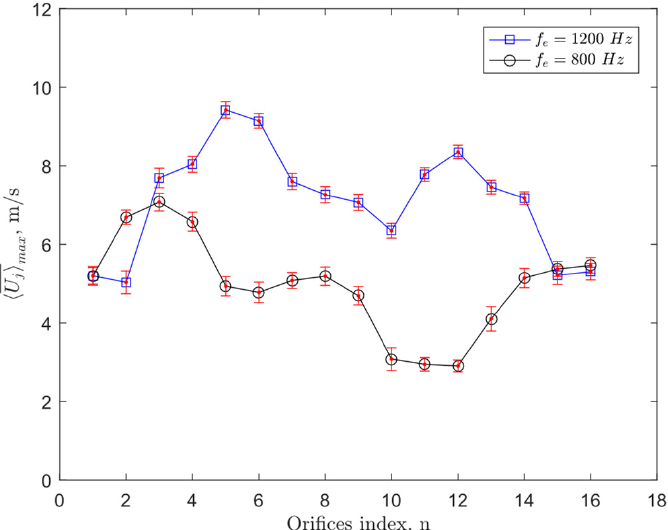
Figure 6. Variation of the peak mean jet velocity during expulsion stroke along the array of orifices at Y/D = 1 (measured at each orifice centreline) for two excitation frequencies ( f e = 800 Hz and 1200 Hz) for the unified-array-cavity volume. Error bars show the standard deviation of measurements at each point. The excitation voltage is E = 150 V pp .